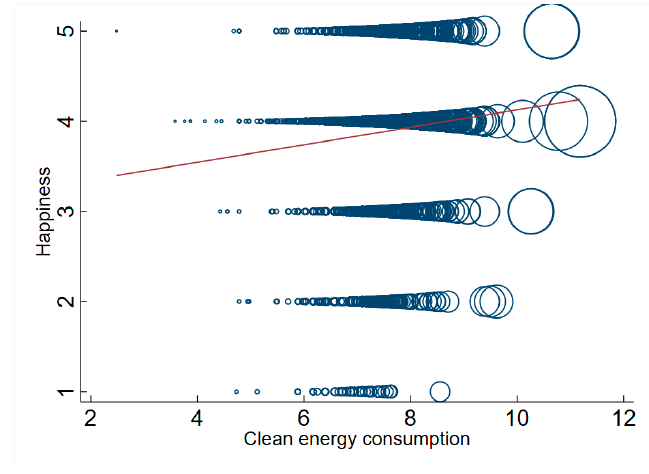
Figure 2. Happiness and clean energy consumption.